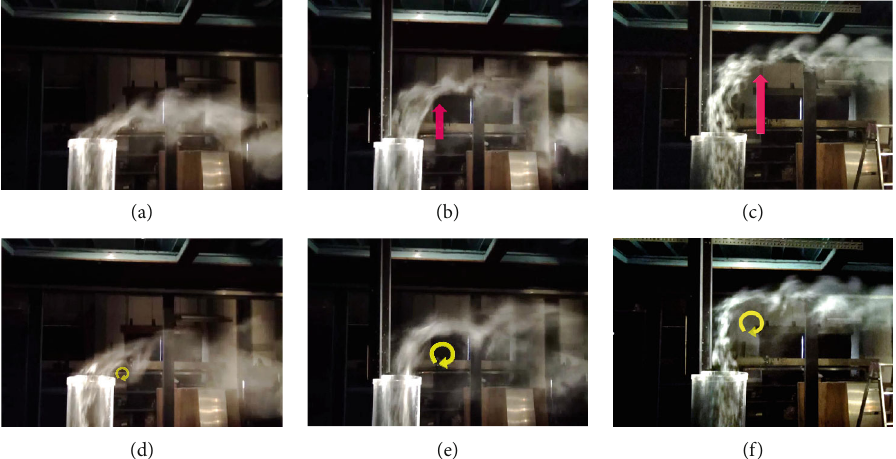
Figure 7: The updraft suctioned up to the top of the vortex generators and large vortices produced by the crosswind: (a) the cylindrical tower without the vortex generator; (b) the cylindrical tower with the vortex generator ( h = D /2 ); (c) the cylindrical tower with the vortex vg = D ); (d) the cylindrical tower without the vortex generator; (e) the cylindrical tower with the vortex generator ( h generator ( h vg = D ). (f) the cylindrical tower with the vortex generator ( h vg